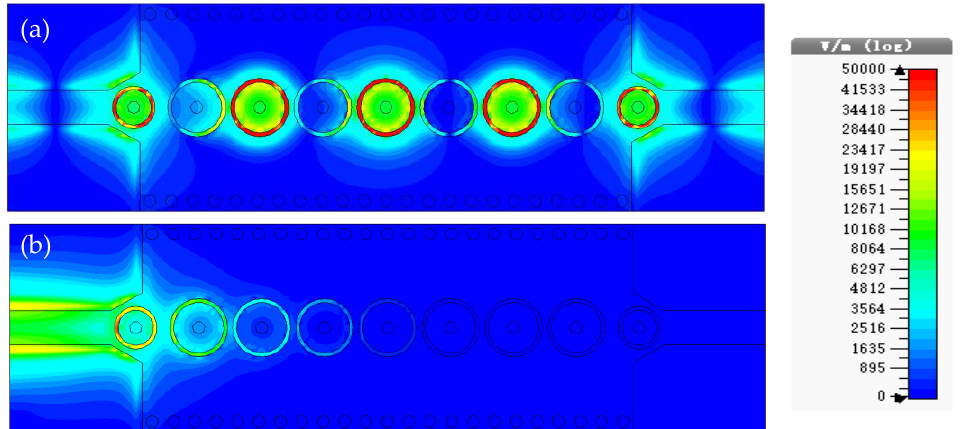
Figure 5. ( a ) Simulated electric field distributions of the BPF based on the proposed SSPP at 20 GHz. ( b ) Simulated electric field distributions at 7 GHz.